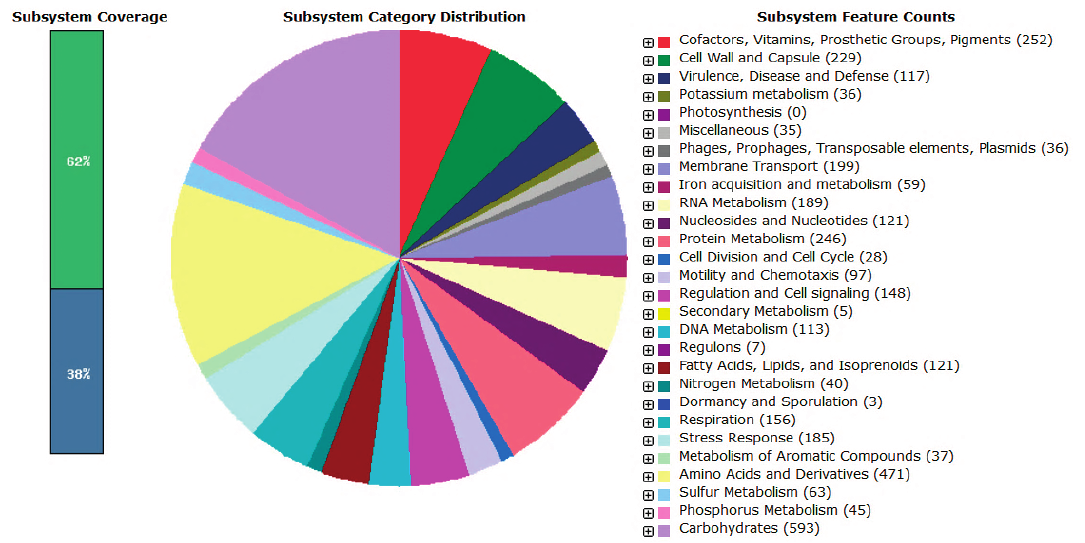
Figure 4. Subsystem category distribution statistics for E. asburiae L1. The complete genome sequence of E. asburiae L1 was annotated using the Rapid Annotation System Technology (RAST) server. The pie chart showed the count of each subsystem feature and the subsystem coverage. The green bar of the subsystem coverage corresponds to the percentage of the proteins included in the subsystems while the blue bar corresponds to the percentage of the proteins that are not included in the subsystems.